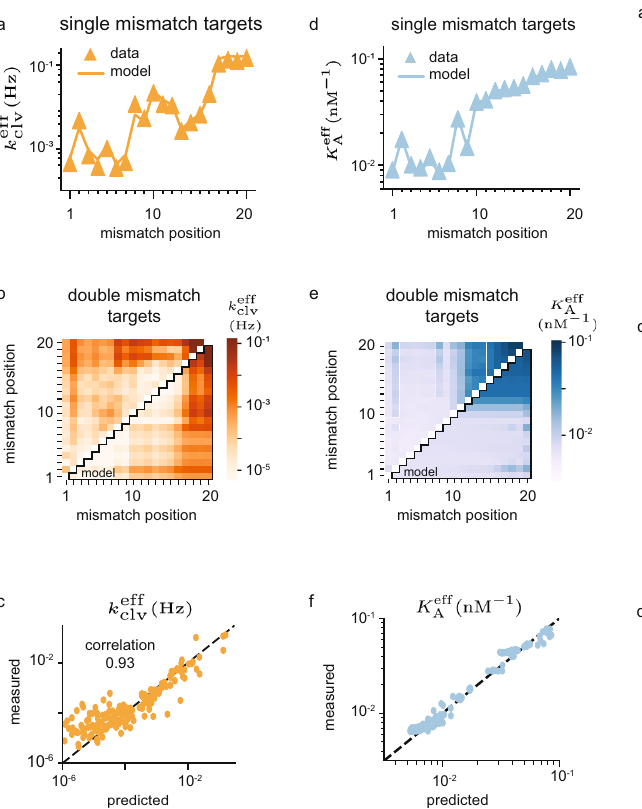
Fig. 2 Training on cleavage and binding for moderately mismatched targets. a Training data (triangles) for effective cleavage rates (NucleaSeq) on single-mismatch targets, and the model estimates (line). b Training data (upper-left triangle) for effective cleavage rate on double-mismatch targets, and the model estimates (lower-right triangle). c Correlation plot for all effective cleavage rate data used for training (single- and double-mismatch targets). d Training data (triangles) for effective association constant (CHAMP) on single-mismatch targets, and the model estimates (line). e Training data (upper-left triangle) for effective association constant on double-mismatch targets, and the model estimates (lower-right triangle). f Correlation plot for all effective association constant data used for training (single- and double-mismatch targets). All data is averaged over mismatch type (see Supplementary Data 1). The quoted correlation coef fi cients are Pearson-correlation coef fi cients, and correlation plots are displayed with log-scales to show the quantitative agreement also for weak targets. The dashed line in the correlation plots correspond to perfect quantitative